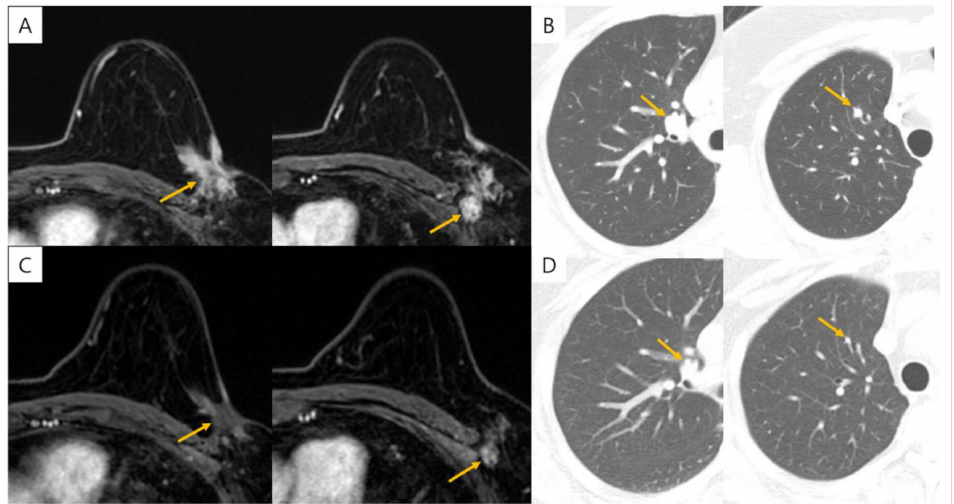
Figure 2. 56-year-old female with breast cancer in Lt breast. ( A ) On initial MRI, there was about a 3.5 cm irregular shape enhancing mass in her Lt breast with skin invasion and multiple metastatic lymph nodes in Lt axilla level I and II. Initial clinical stage was III based on MRI. ( B ) Multiple metastatic pulmonary nodules were detected on staging chest CT and clinical stage was upstaged from stage III to IV. ( C ) After neoadjuvant chemotherapy, primary breast mass and axillary lymph nodes decreased in size. ( D ) Pulmonary metastatic nodules also decreased in size after neoadjuvant chemotherapy, consistent with the response of primary